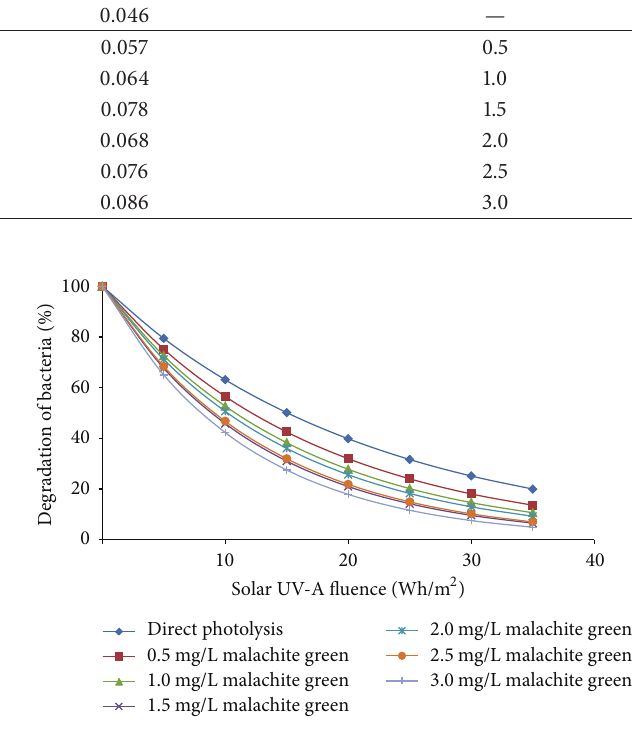
Figure 6: Photodegradation of microbial pollutant faecal coliforms as a function of solar UV fluence, with direct photolysis and photosensitiser malachite green